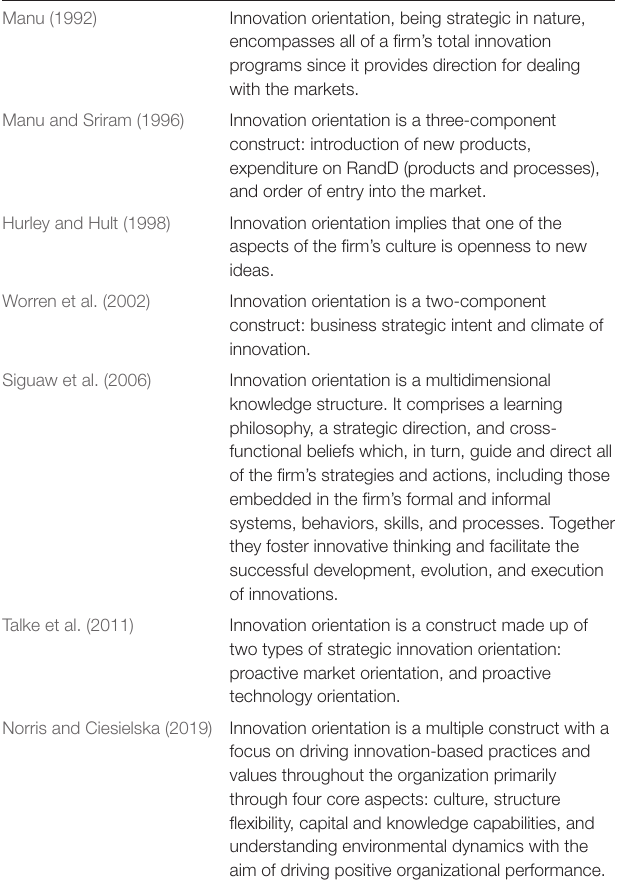
TABLE 1 | Definitions of innovation orientation.